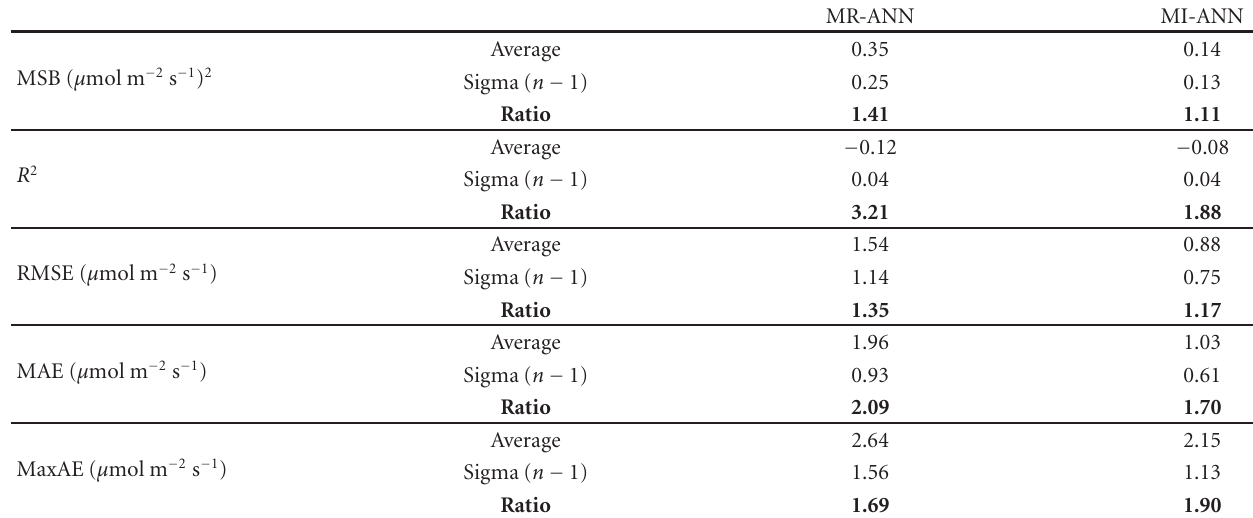
Table 7: Statistical